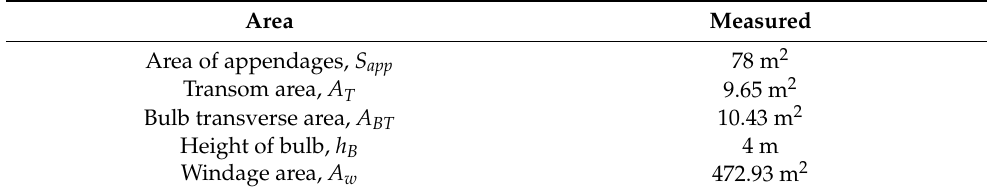
Table 5. Specifications of major components.